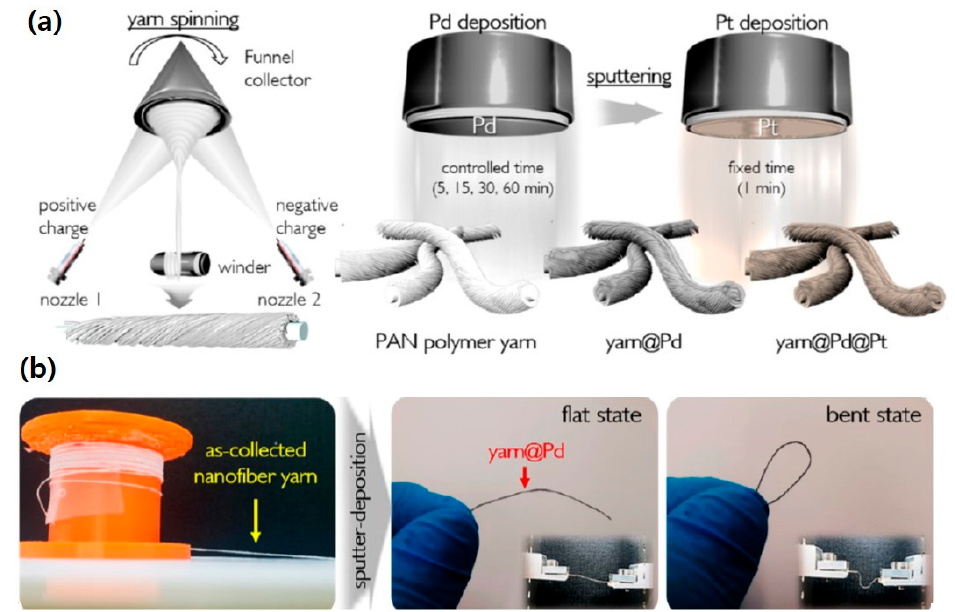
Figure 12. ( a ) Schematic illustration of yarn spinning followed by a metal deposition process, and ( b ) photographs of as-fabricated nanofiber yarn and Pd-coated yarn. [Adapted with permission from 101. Copyright (2019) American Chemical Society].